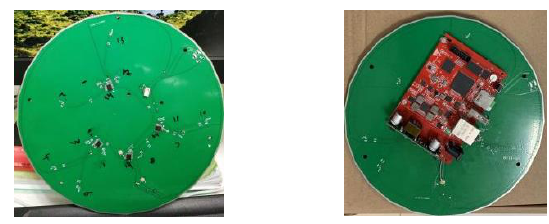
Figure 4. The hardware of the array antenna and source.